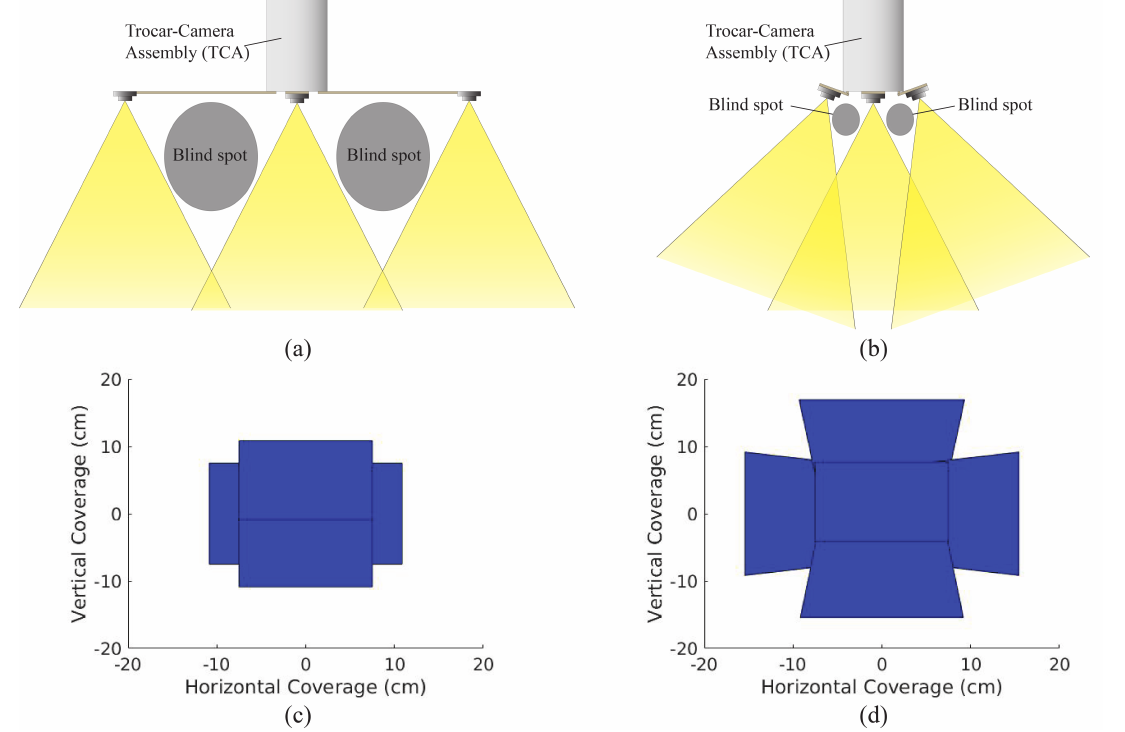
Figure 1. Field of View (FoV) Coverage: Careful choice of camera placement can reduce blind spots ( a , b ) while increasing total FoV ( c , d ) at the bottom of the trainer box (depth = 16.5